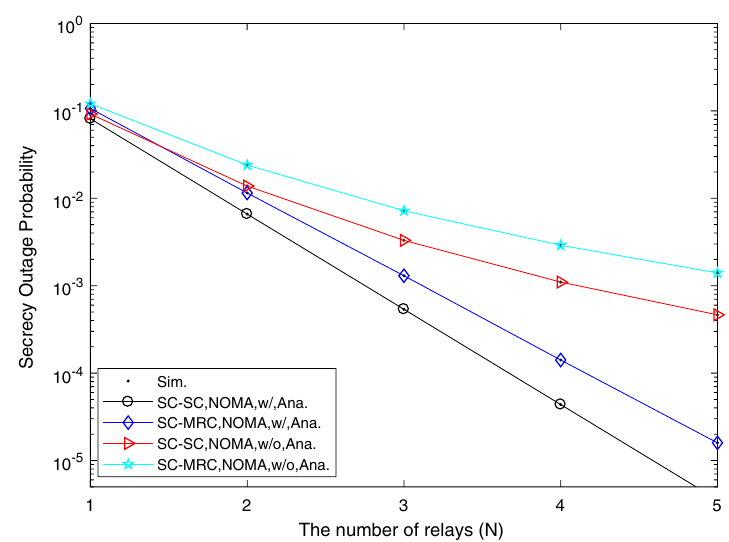
Fig. 6 SOP for the different number of relays. When the transmission power is constant, the influence of different number of relays is on the